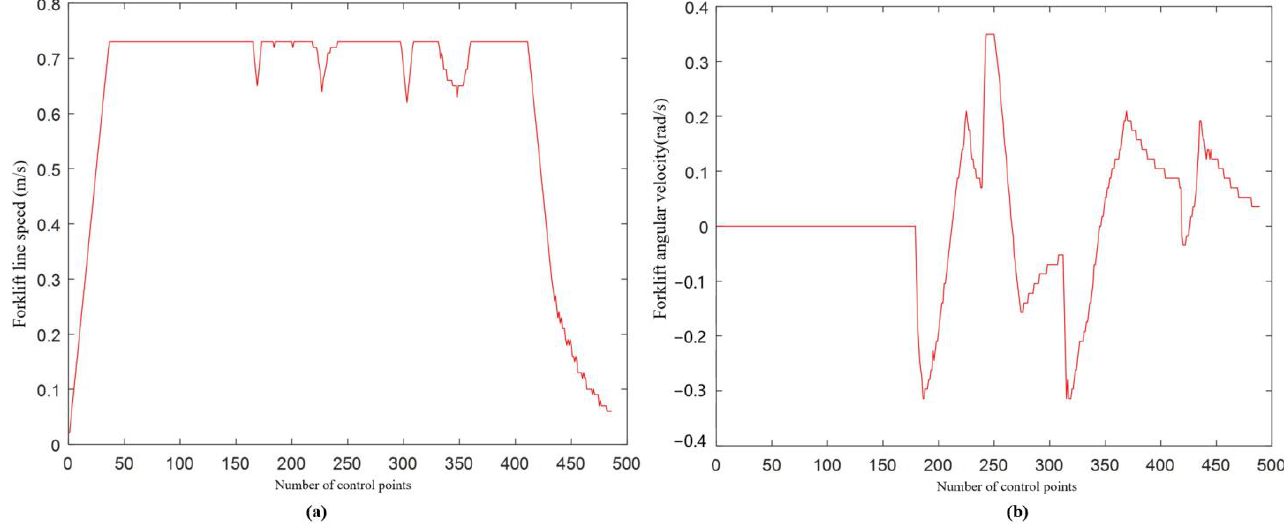
Figure 10. Simulation results of original evaluation function: ( a ) linear speed of FAGV ( b ) angular velocity of FAGV.